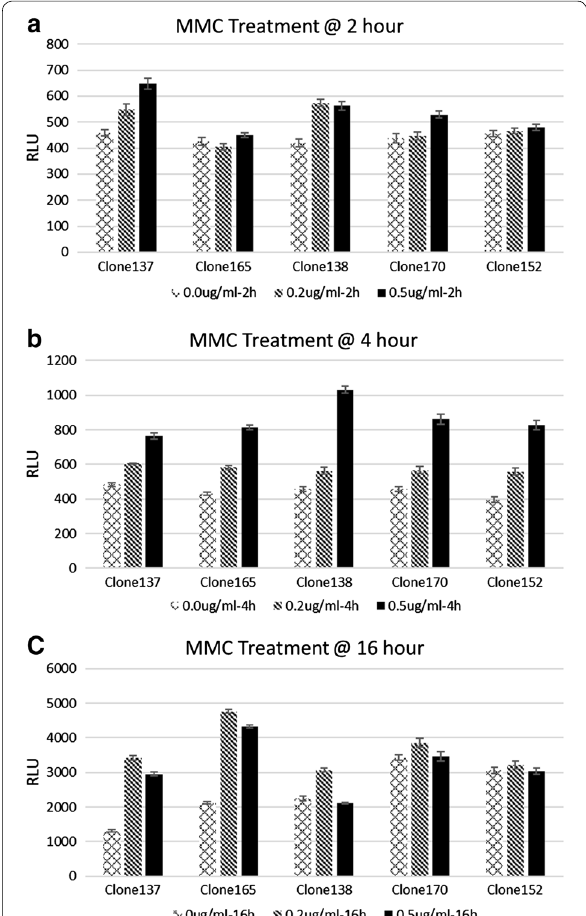
Fig. 2 Analysis of LexA-containing clones in response to mitomycin C treatment. From protein-bound genomic DNA fragment libraries, five clones containing LexA binding sequences were identified through sequencing and TFBS motif search. These clones were selected and treated with 0, 0.2 and 0.5 μM mitomycin C for 2 ( a ), 4 ( b ), and 16 h ( c ) respectively. Cells were collected for luciferase